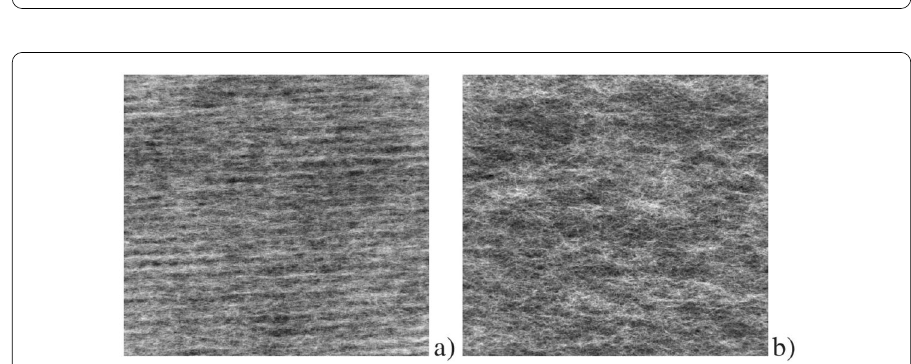
Figure 11 Pixelwise mean of the normalized local grammages of anisotropic nonwovens a) FL2 and b) FL3, 2048 × 2048 pixels of size 6.734 μ m. The mean was computed from m = 10 separate images of a total area 1902.0 mm